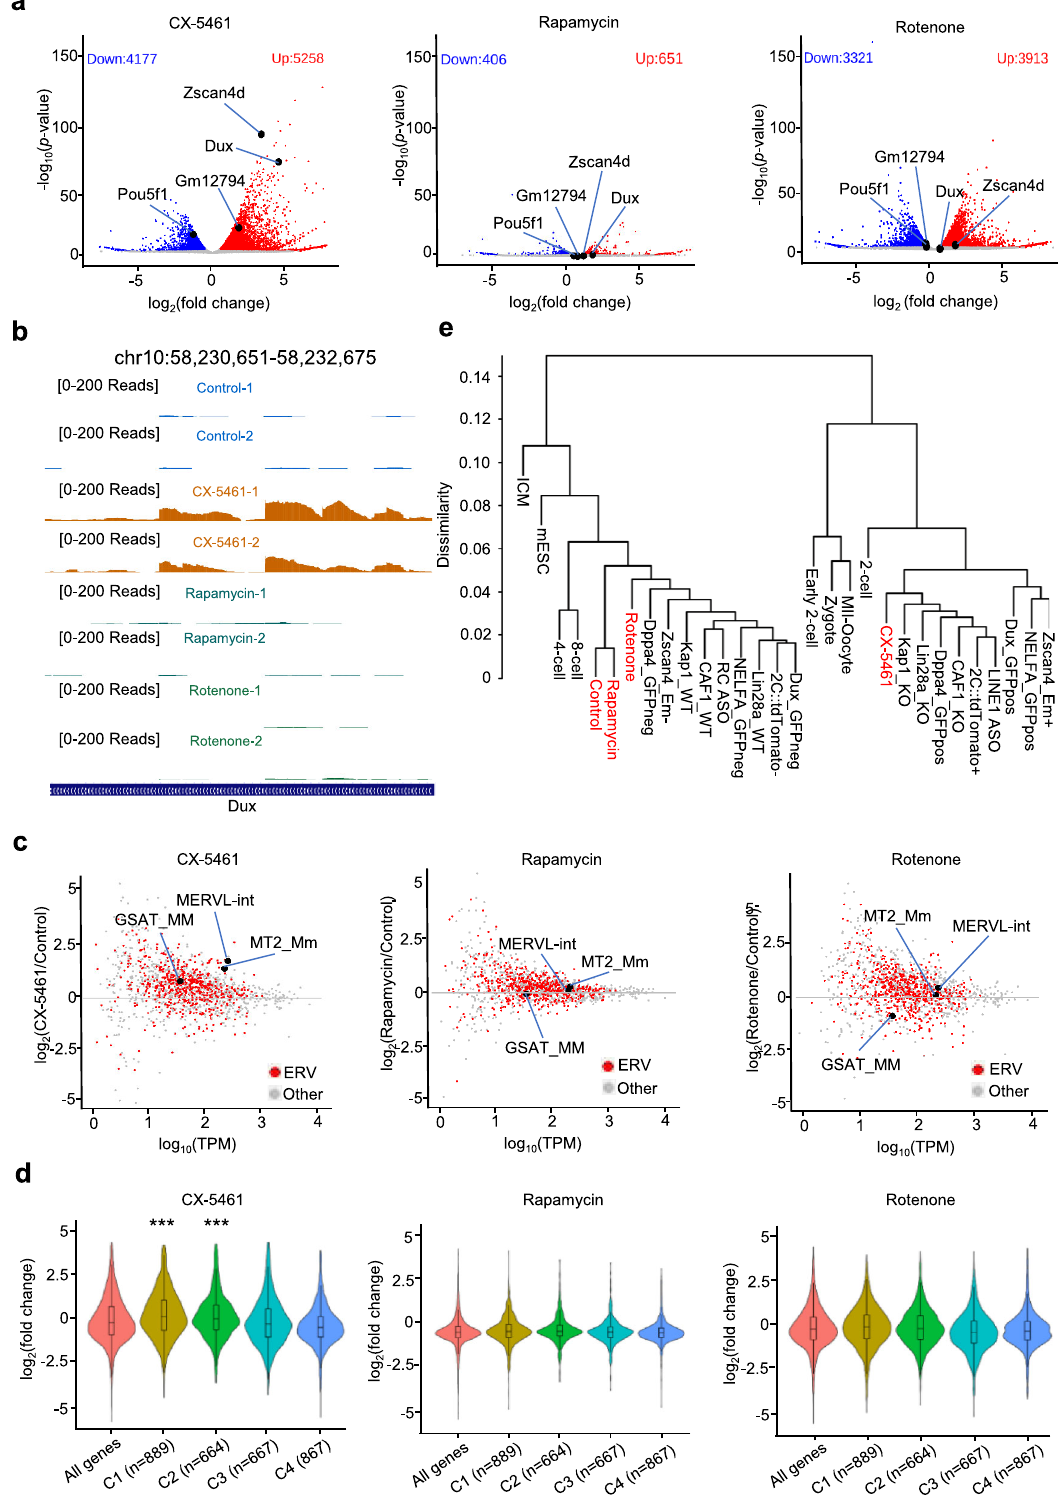
De fi ciency of rRNA biogenesis disrupted the normal state of nucleolar liquid – liquid phase separation (LLPS) and the epi- genetic state of the PNH . As it has been reported that ribosomal RNA plays a critical role in maintaining phase separation of nucleolus 35 – 37 and phase transition is involved in nucleolar stress 37,38 , we examined whether nucleolar stress induced by rRNA biogenesis defect leads to changes of nucleolar phase